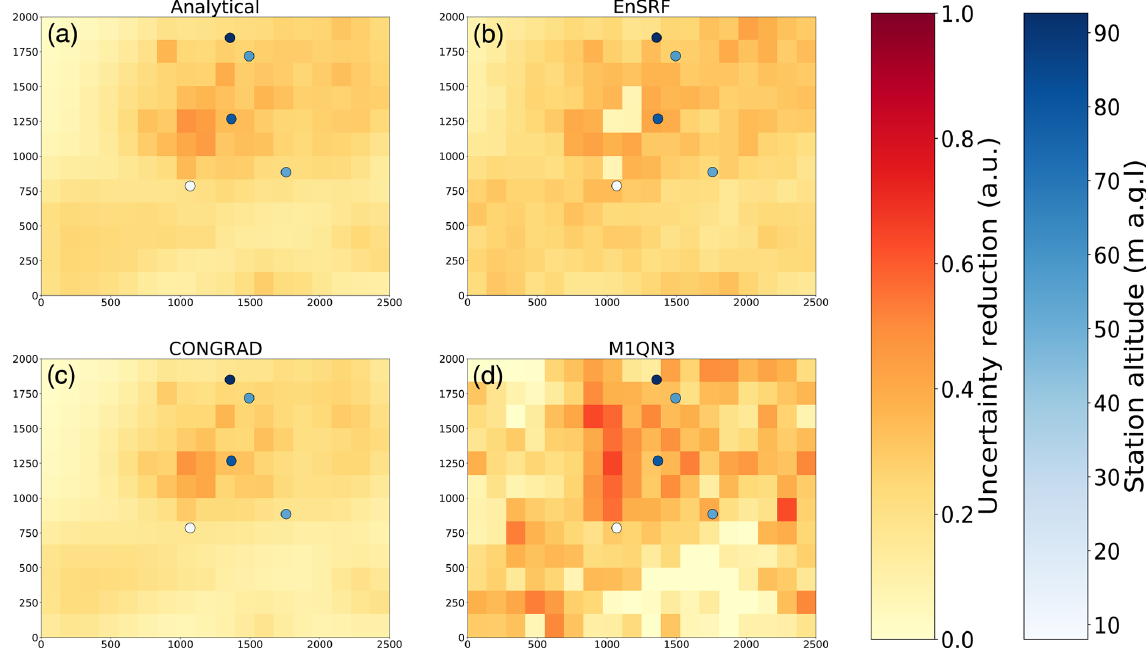
Figure 6. Uncertainty reduction for analytical, EnSRF, variational with CONGRAD and variational with M1QN3 (from top to bottom, left to right) with the same set-up as in Fig.